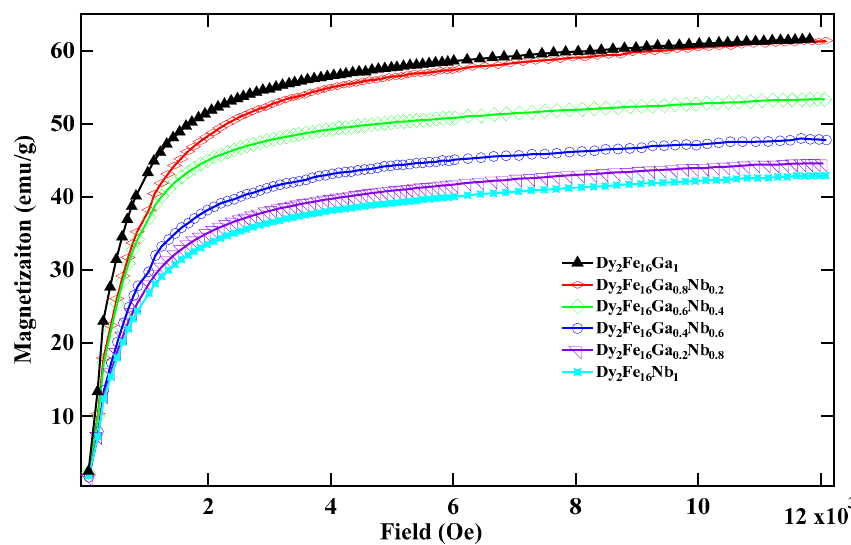
on Co 1 − x Nb x alloy, cobalt moment was observed to decrease with increasing Nb content in the alloys due to a similar hybridization effect [32].